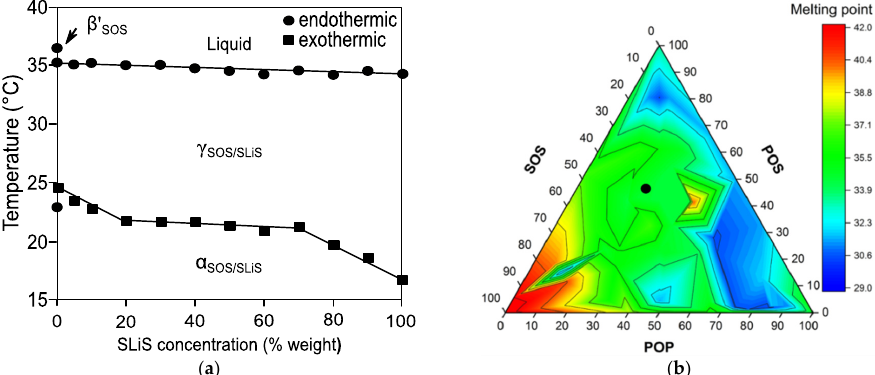
Figure 11. Phase diagrams of saturated- cis -unsaturated TAG systems exhibiting complete (SOS/SLiS) and partial (POP/POS/SOS) solid-state miscibility. ( a ) Binary phase behavior of SOS/SLiS system and partial (POP / POS / SOS) solid-state miscibility. ( a ) Binary phase behavior of SOS / SLiS system during during heating at 2 °C·min − 1 soon after cooling at 20 °C·min − 1 . Reprinted with permission from [137], heating at 2 ◦ C · min − 1 soon after cooling at 20 ◦ C · min − 1 . Reprinted with permission from [137], © 2002 © 2002 American Oil Chemist’s Society. ( b ) Ternary melting phase diagram of POP/POS/SOS American Oil Chemist’s Society. ( b ) Ternary melting phase diagram of POP / POS / SOS mixtures in the mixtures in the β 2 polymorph. Reprinted with permission from [55], © 2019 American Chemical © 2019 American Chemical β Society. 2 polymorph. Reprinted with permission from [55],